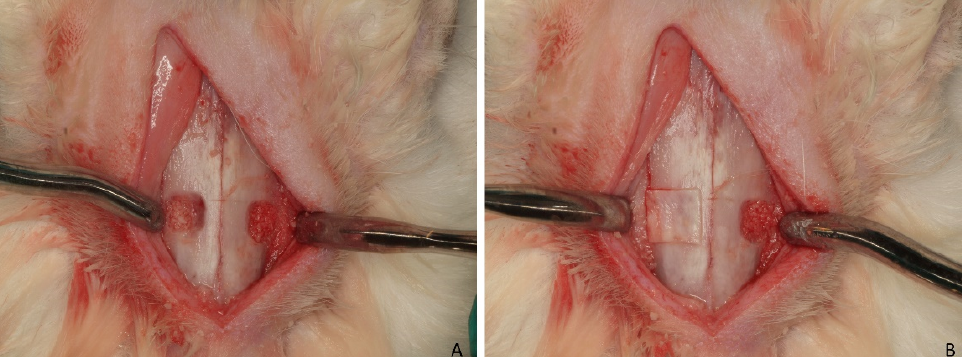
Figure 1. ( A ) Skin and periosteum were elevated separately, and the nasal bone was exposed. The osteotomies were prepared bilaterally, and the elevated spaces were filled with the graft material. ( B ) At one site a collagen membrane was placed to cover the osteotomy, and at the other site the periosteum was directly sutured above the graft material.